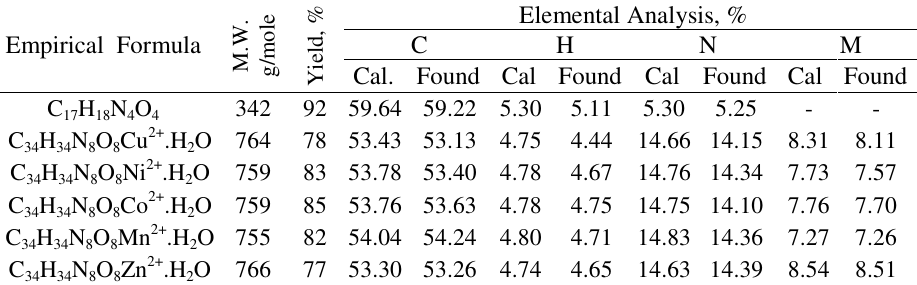
Table 1. Analysis of MIPQ ligand and its